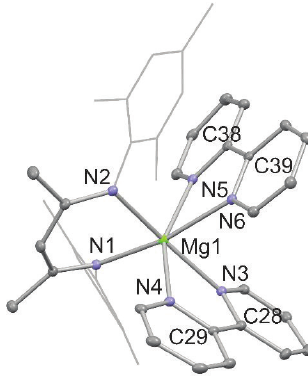
Figure 2: Thermal ellipsoid plot (25% probability surface) of the molecular structure of 3 (hydrogen atoms omitted; Mes groups shown as wireframe for clarity). Selected bond lengths (Å) and angles (°): Mg(1)-N(1) 2.1583(14), Mg(1)-N(3) 2.1783(13),